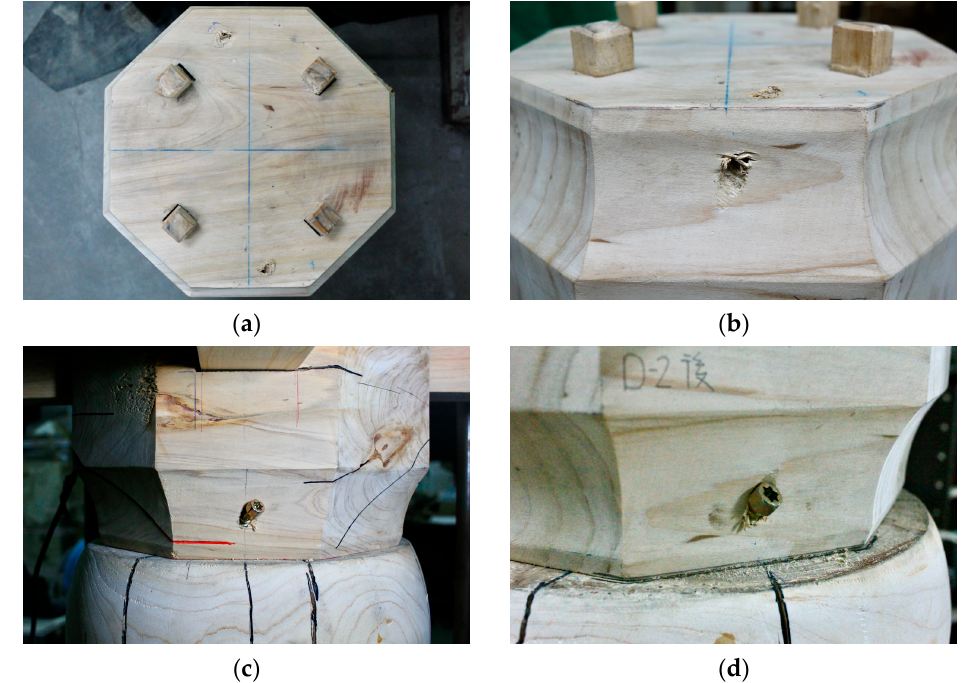
Figure 16. Failure modes of Zuo-Dou after shear test: ( a ) hole of the STS, specimen No. 2; ( b ) hole caused by STS, specimen No. 2; ( c ) STS in Zuo-Dou connection, specimen No. 4; ( d ) STS in Zuo-Dou joint, specimen No. 5.